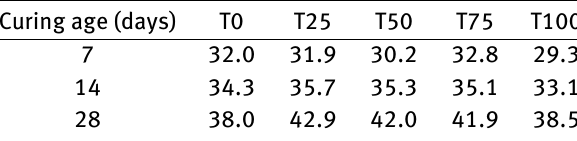
Table 2: Compressive strength of concrete with and without tailings